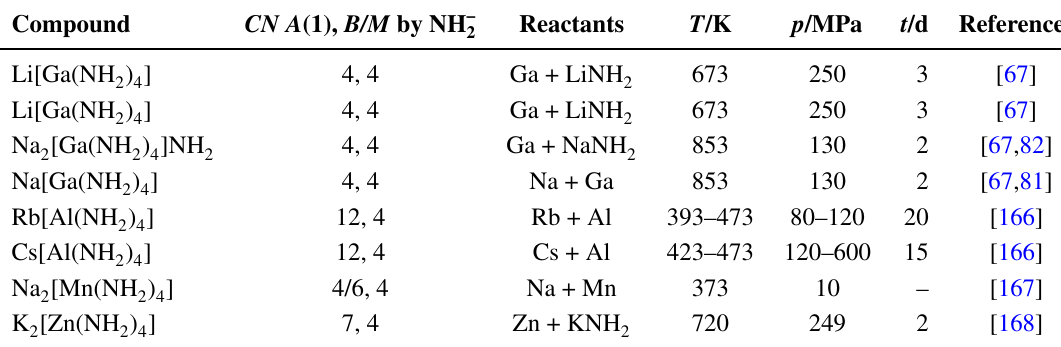
Table 7. Conditions for the ammonothermal synthesis of ternary amides of main group and transition metals and coordination numbers of the metal atoms by amide